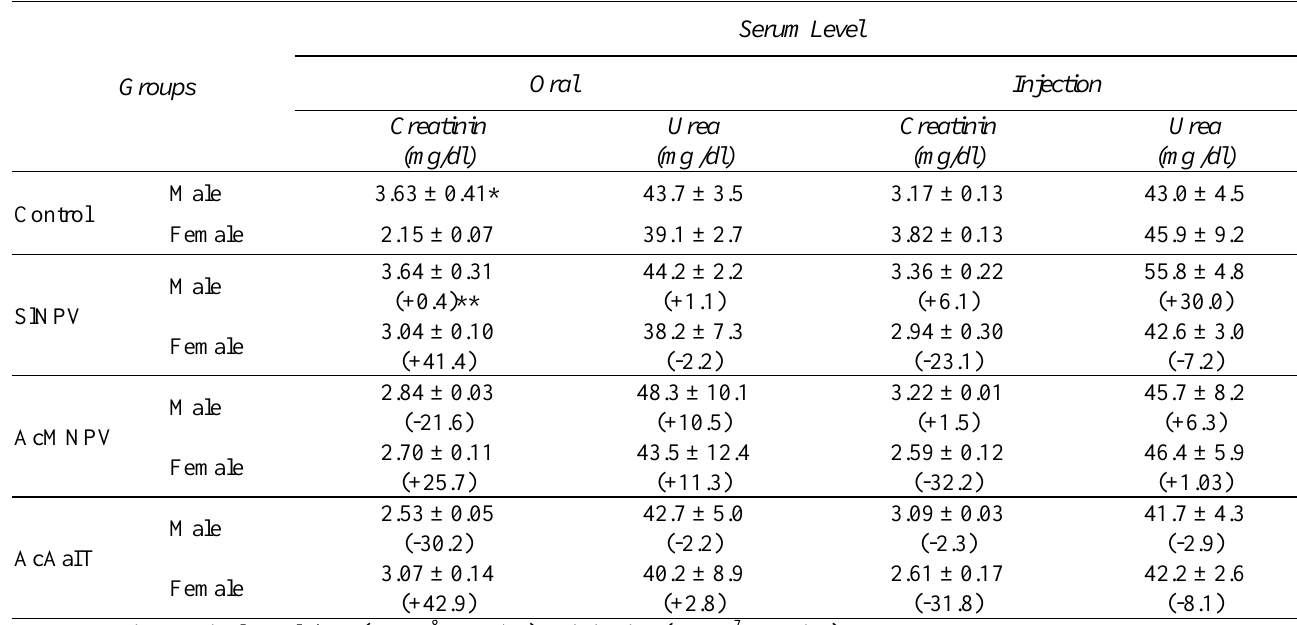
Table 9: Levels creatinin and urea in rat serum at 21 days after oral or intraperitoneal administration of SlNPV, AcMNPV or